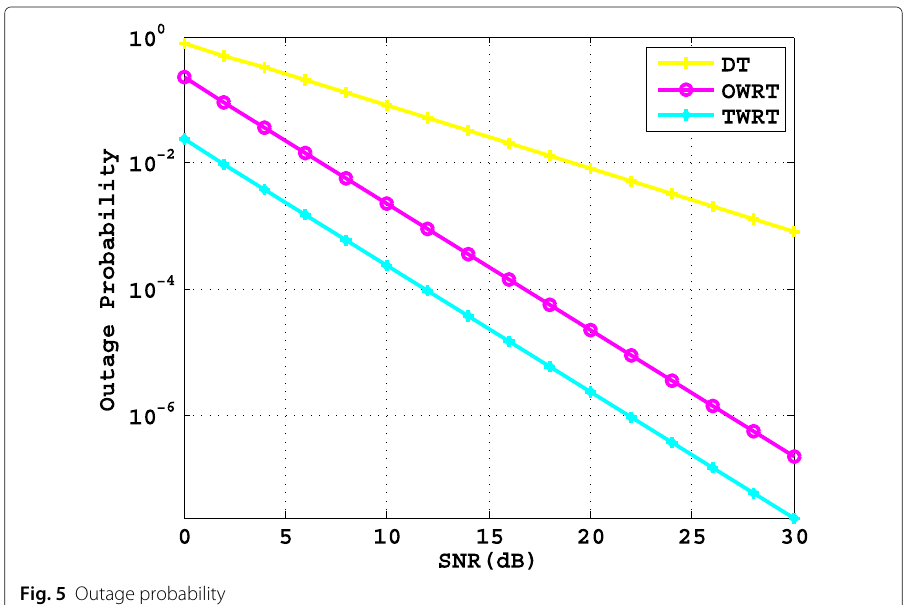
Fig. 5 Outage probability